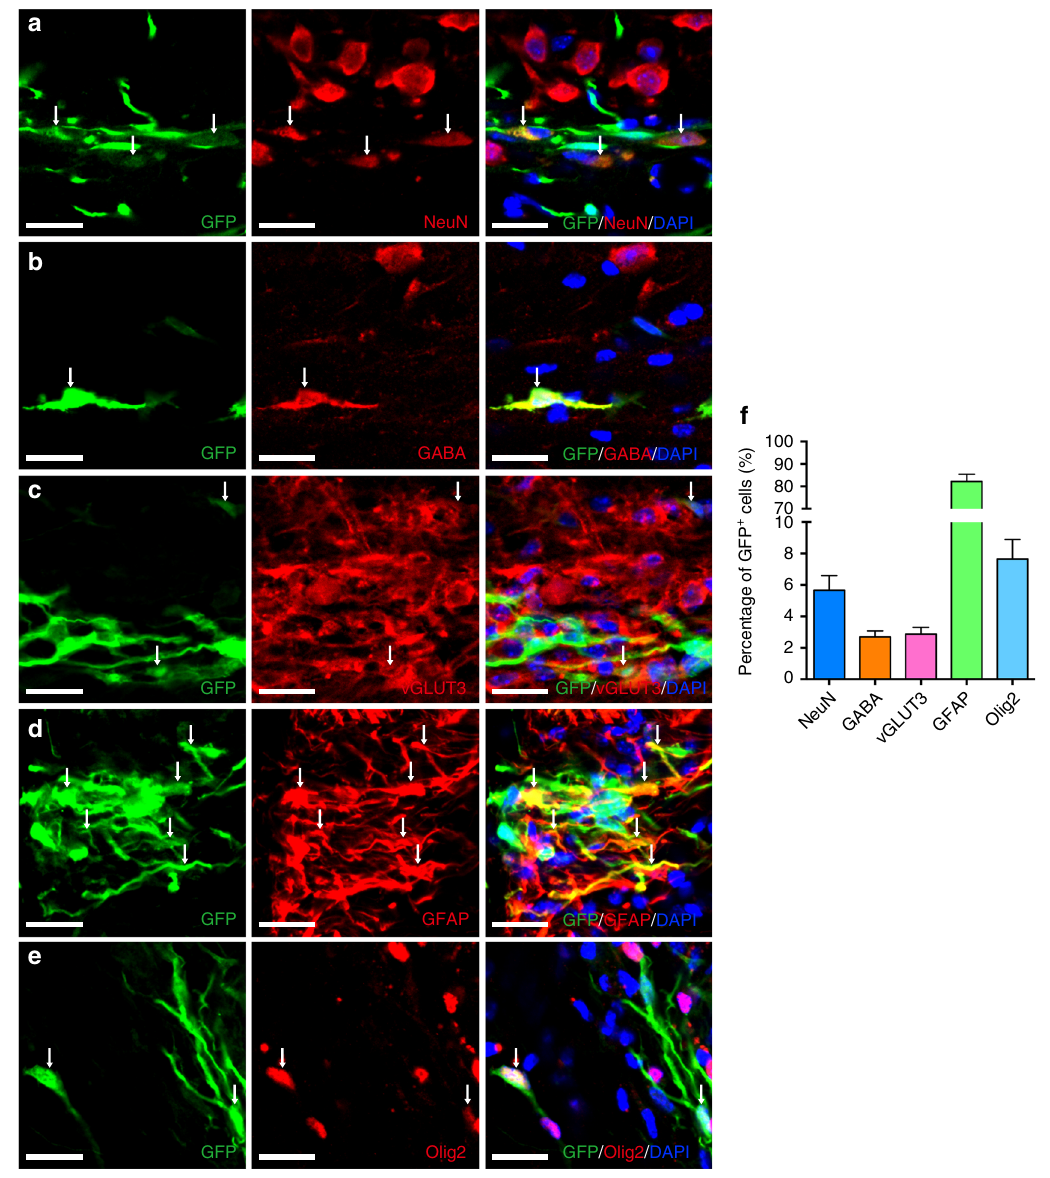
Fig. 10 In vivo differentiation potential of Ptf1a-reprogrammed hiNSCs. a – e GFP-tagged hiNSCs transplanted into the mouse hippocampus differentiated into neurons immunoreactive for NeuN, GABA, or vGLUT3 ( a – c ), astrocytes immunoreactive for GFAP ( d ), or oligodendrocytes immunoreactive for Olig2 ( e ). Cells in a – e were counterstained with nuclear DAPI. Arrows point to representative colocalized cells and/or processes. f Quanti fi cation of GFP + cells that are immunoreactive for NeuN, GABA, vGLUT3, GFAP, or Olig2. Scale bars, 20 μ m ( a – e